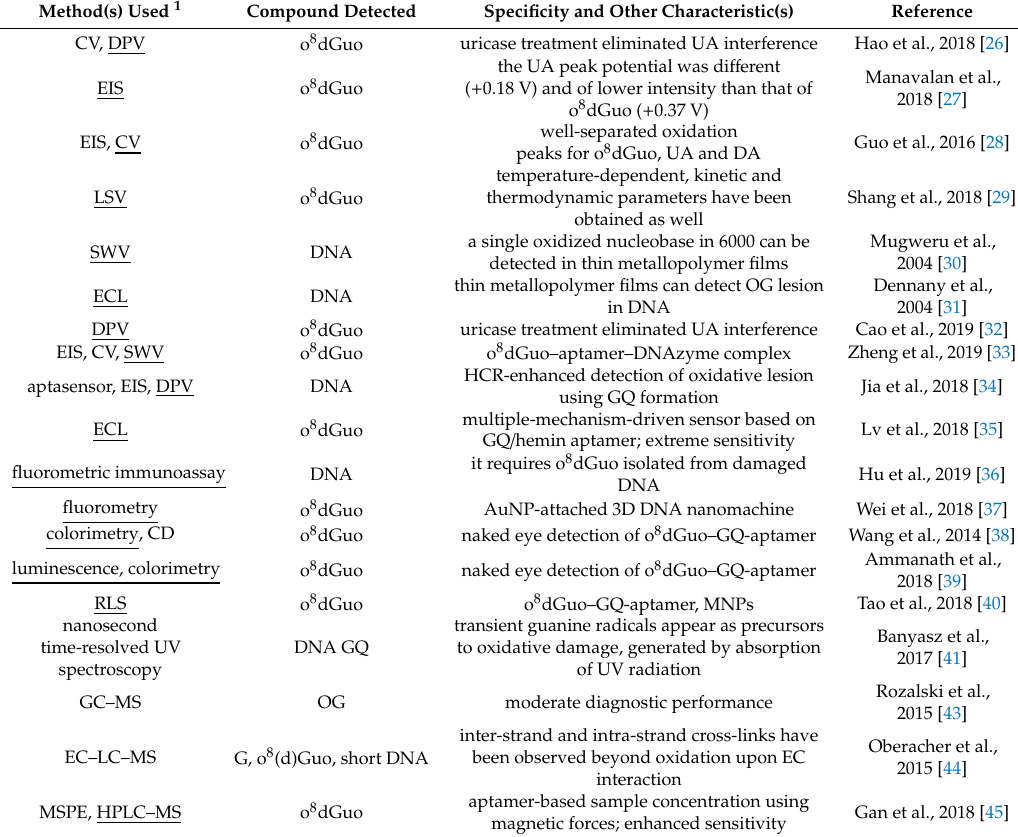
Table 1. The special characteristics of analytical methods used in the identification of oxidative lesion of guanine in nucleic acid